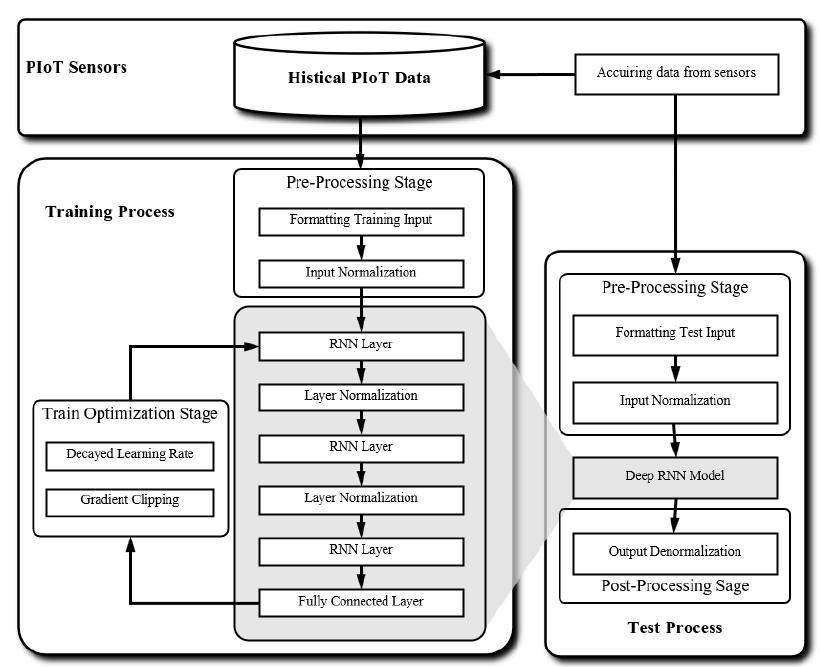
Figure 5. The proposed deep RNN to forecast PV power